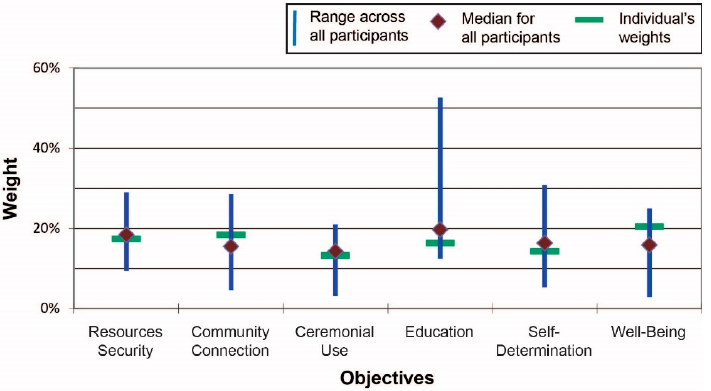
Figure 4. Scenario 2 (river clean up) results (At the time of the workshops, the “Resilience” indicator was called “Well-Being”.).